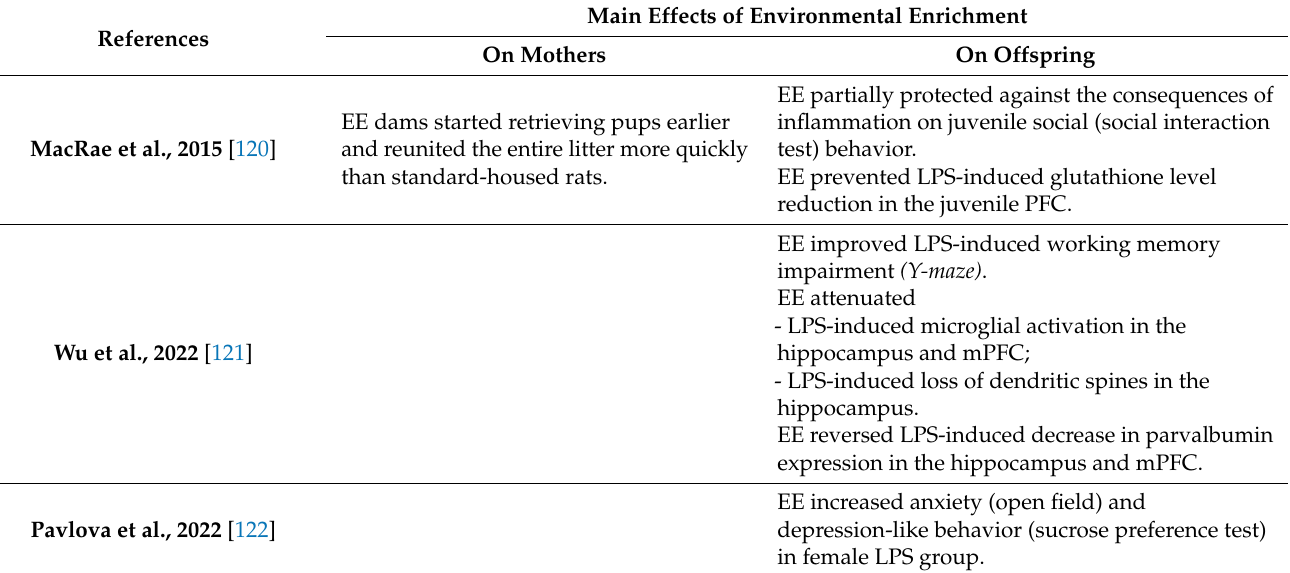
Table 4. Main effects of environmental enrichment in case of early postnatal